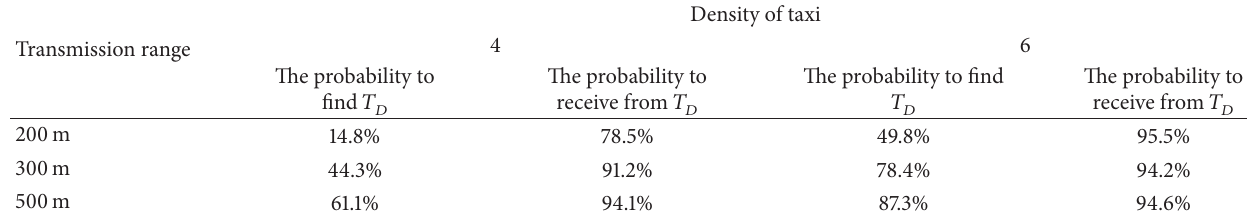
Table 3: The impact of nodes density and transmission range on successful calling ratio.